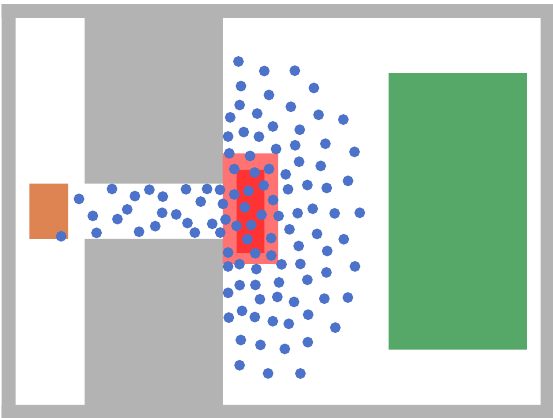
Figure 3. Snapshot of a simulation of the bottleneck scenario used for the sensitivity analysis after 30